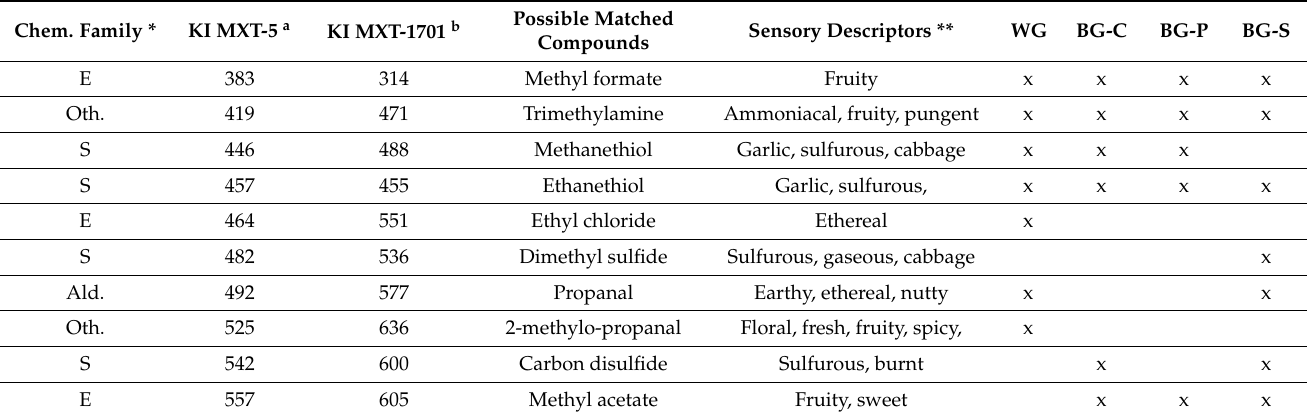
Table 2. Characterization of the main volatile compounds identified in the headspace of fresh garlic, black garlic, black garlic powder and